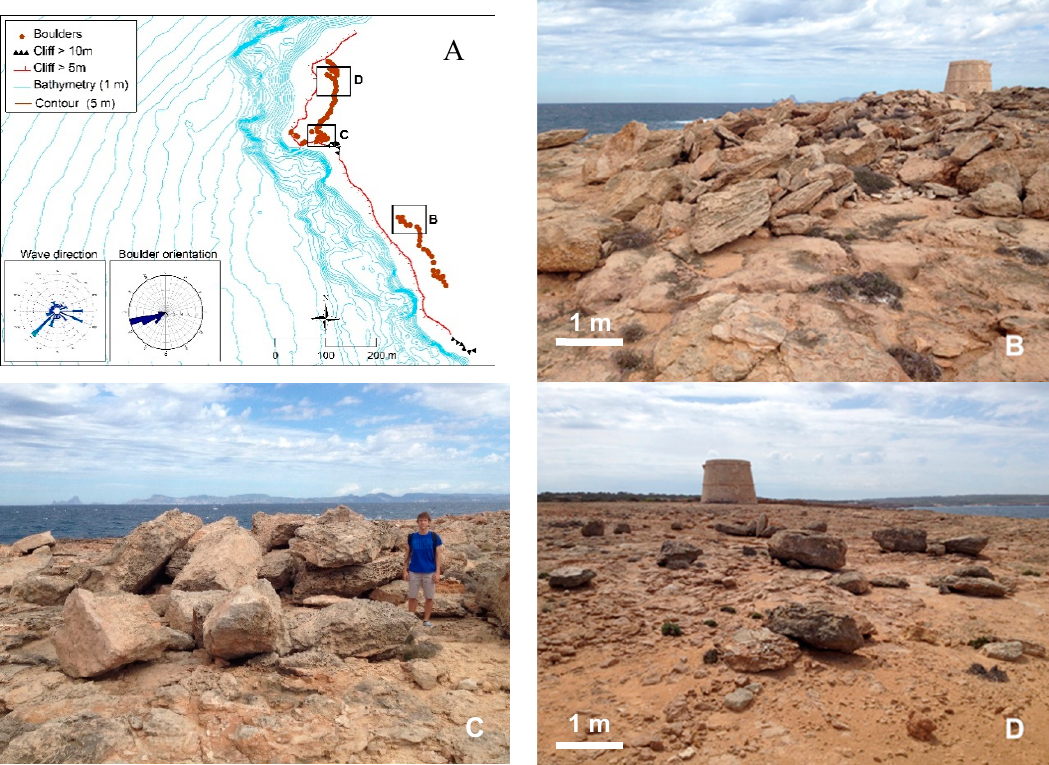
Figure 11. ( A ) Geomorphological scheme of the Punta de sa Gavina area. Roses show the dominant wave winds ( left ) and the dominant block orientation ( right ). ( B ) Groups of imbricated boulders at 7 m a.s.l., and 25 m from the cliff ledge. ( C ) Imbricate boulders of large dimensions 37 m from the cornice, and 8.5 m a.s.l. ( D ) Boulders deposited more than 85 m from the cliff ledge, and 9.5 m a.s.l.